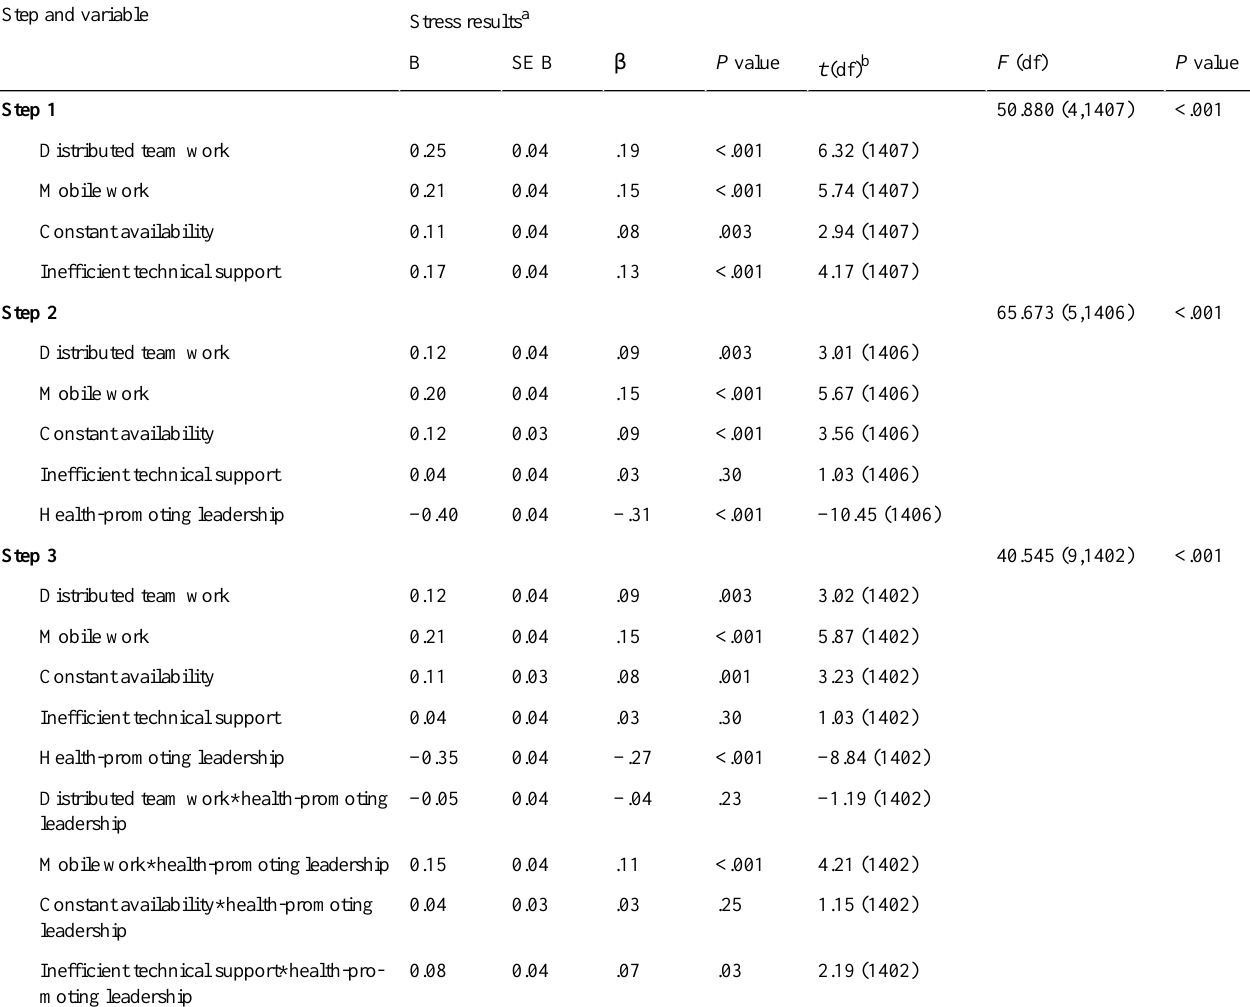
Table 4. Results of hierarchical multiple regression analyses for the criterion stress (R2=20.7%).